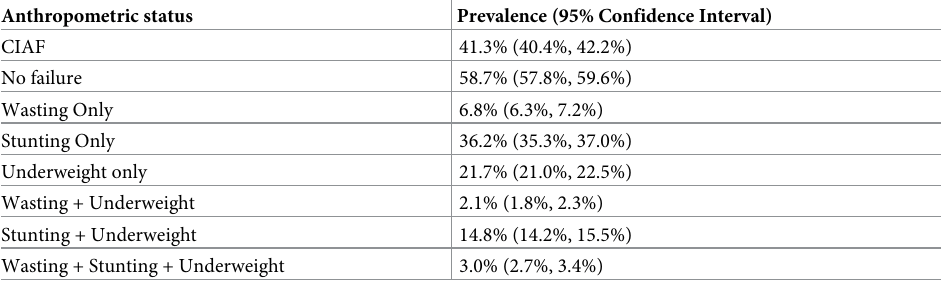
Table 4. Prevalence of the different forms of anthropometric failure of the children in the 2018 NDHS